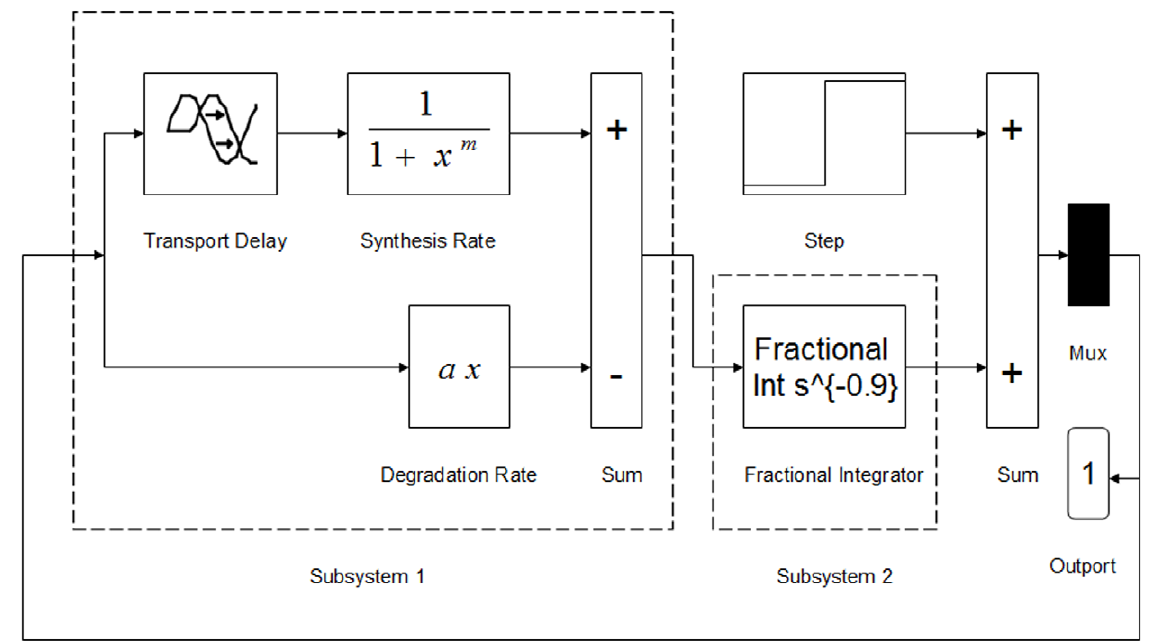
Figure 4. Simulink block diagram of the fractional delay Goodwin oscillator. Subsystem 1 containing a block of Transport Delay possesses the time lag effect, while subsystem 2 is a fractional integrator (with order of 0.9) which reflects the fading memory effect. The Step block is used for assigning the initial value in the beginning step, and the Outport block is used for collecting the simulation results.